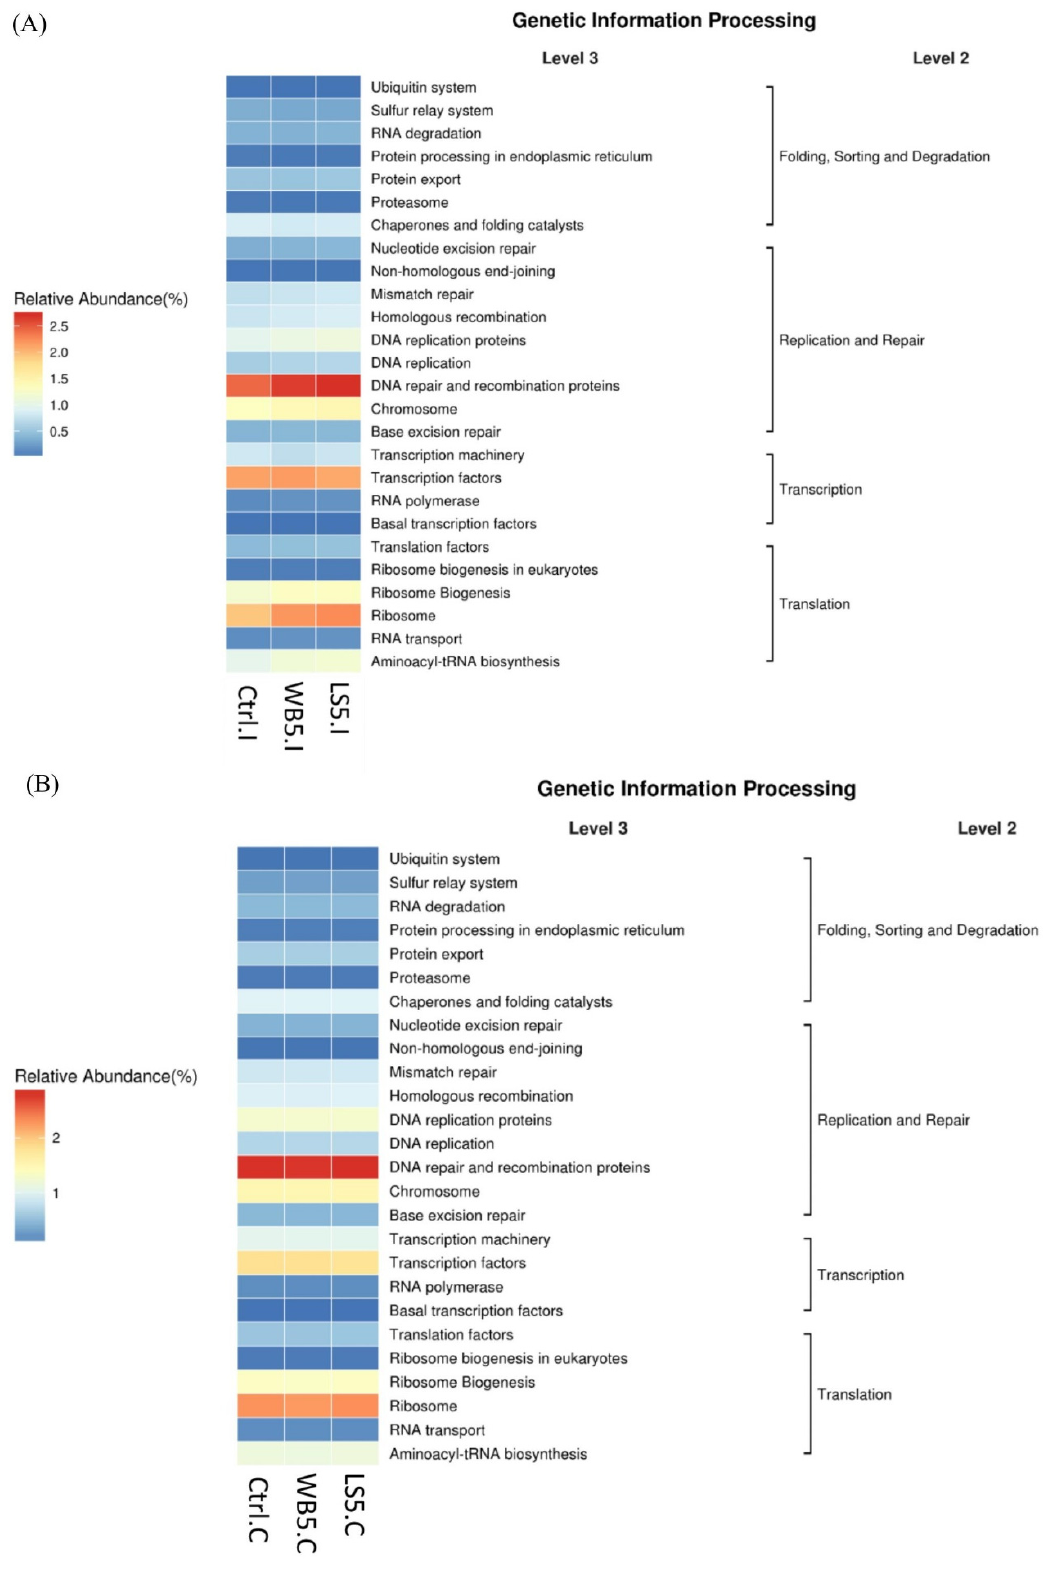
Figure 6. Effects of LS on the KEGG pathway in the ileum ( A ) and cecum ( B ) of broilers. Ctrl: control group; WB5: broilers supplemented with 5% wheat bran; LS5: broilers supplemented with 5% Laetiporus sulphureus wheat bran. Results are means of six samples obtained from the individual birds of each of the control and experimental groups.